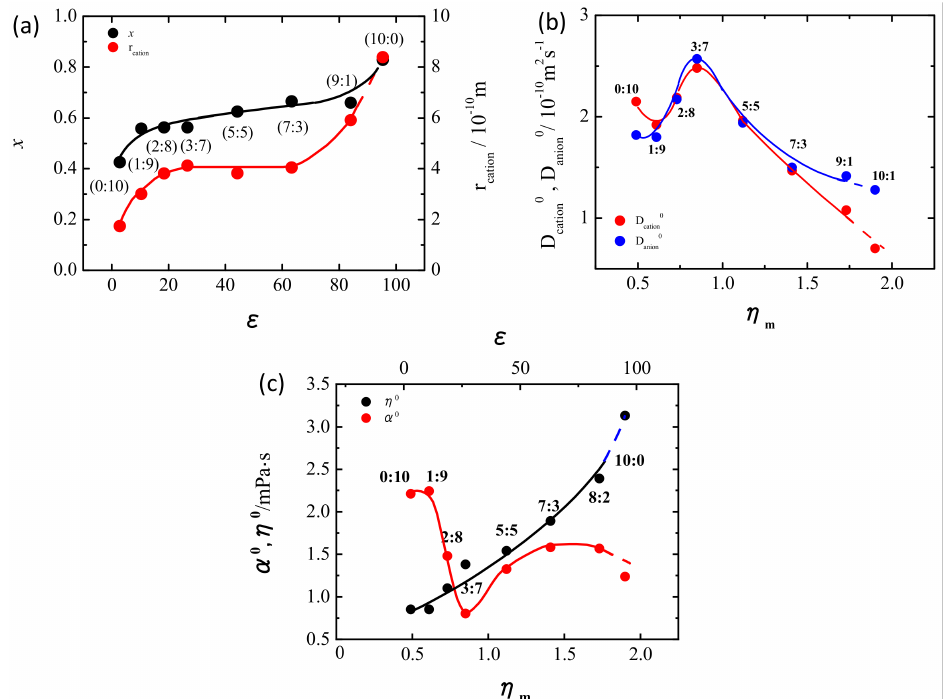
Figure 3. ( a ) Dissociation degree of the salt, x and the radius of the cation species, r cation , ( b ) inherent diffusion coefficients of the cation, D 0 cation , and anion, D 0 anion , and ( c ) microviscosities, η 0 and α 0 , of the 1 M electrolyte solution, lithium bis(trifluoromethanesulfonyl)imide/ethynatelene carbonate + dimethyl carbonate (LiTFSI/EC+DMC) with changing the wt. mixing ratio of (EC:DMC) as shown in the figure, as functions of macroscopic dielectric constant, ε and bulk viscosity, η m of the solution. The lithium salt, LiTFSI, was selected in this research due to the higher stability in the solvent to obtain reliable comparison data. Reprinted with permission from [17]. Copyright 2012 ACS